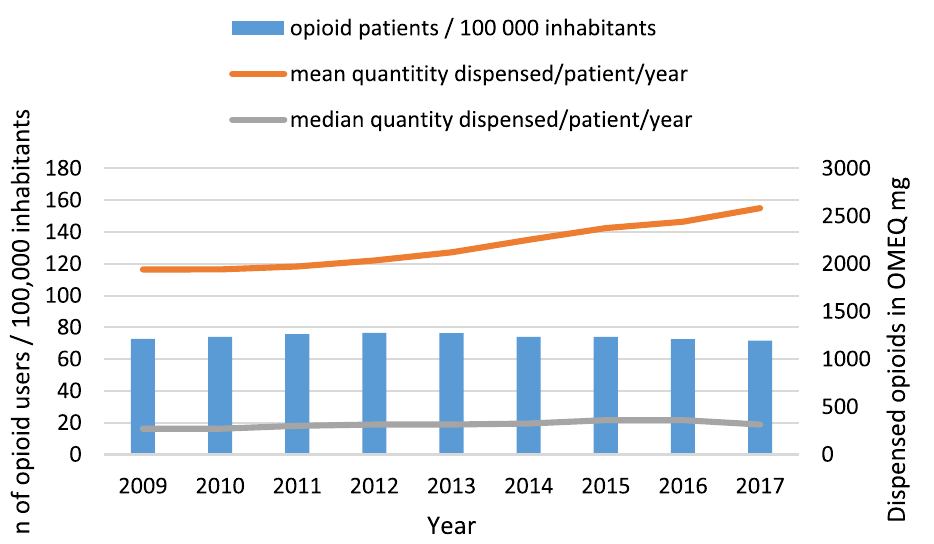
Figure 1. Number of patients who had been dispensed opioids per 100,000 inhabitants, and the mean and median quantity of opioids dispensed per patient per year in oral morphine equivalents (OMEQ mg) in 2009-